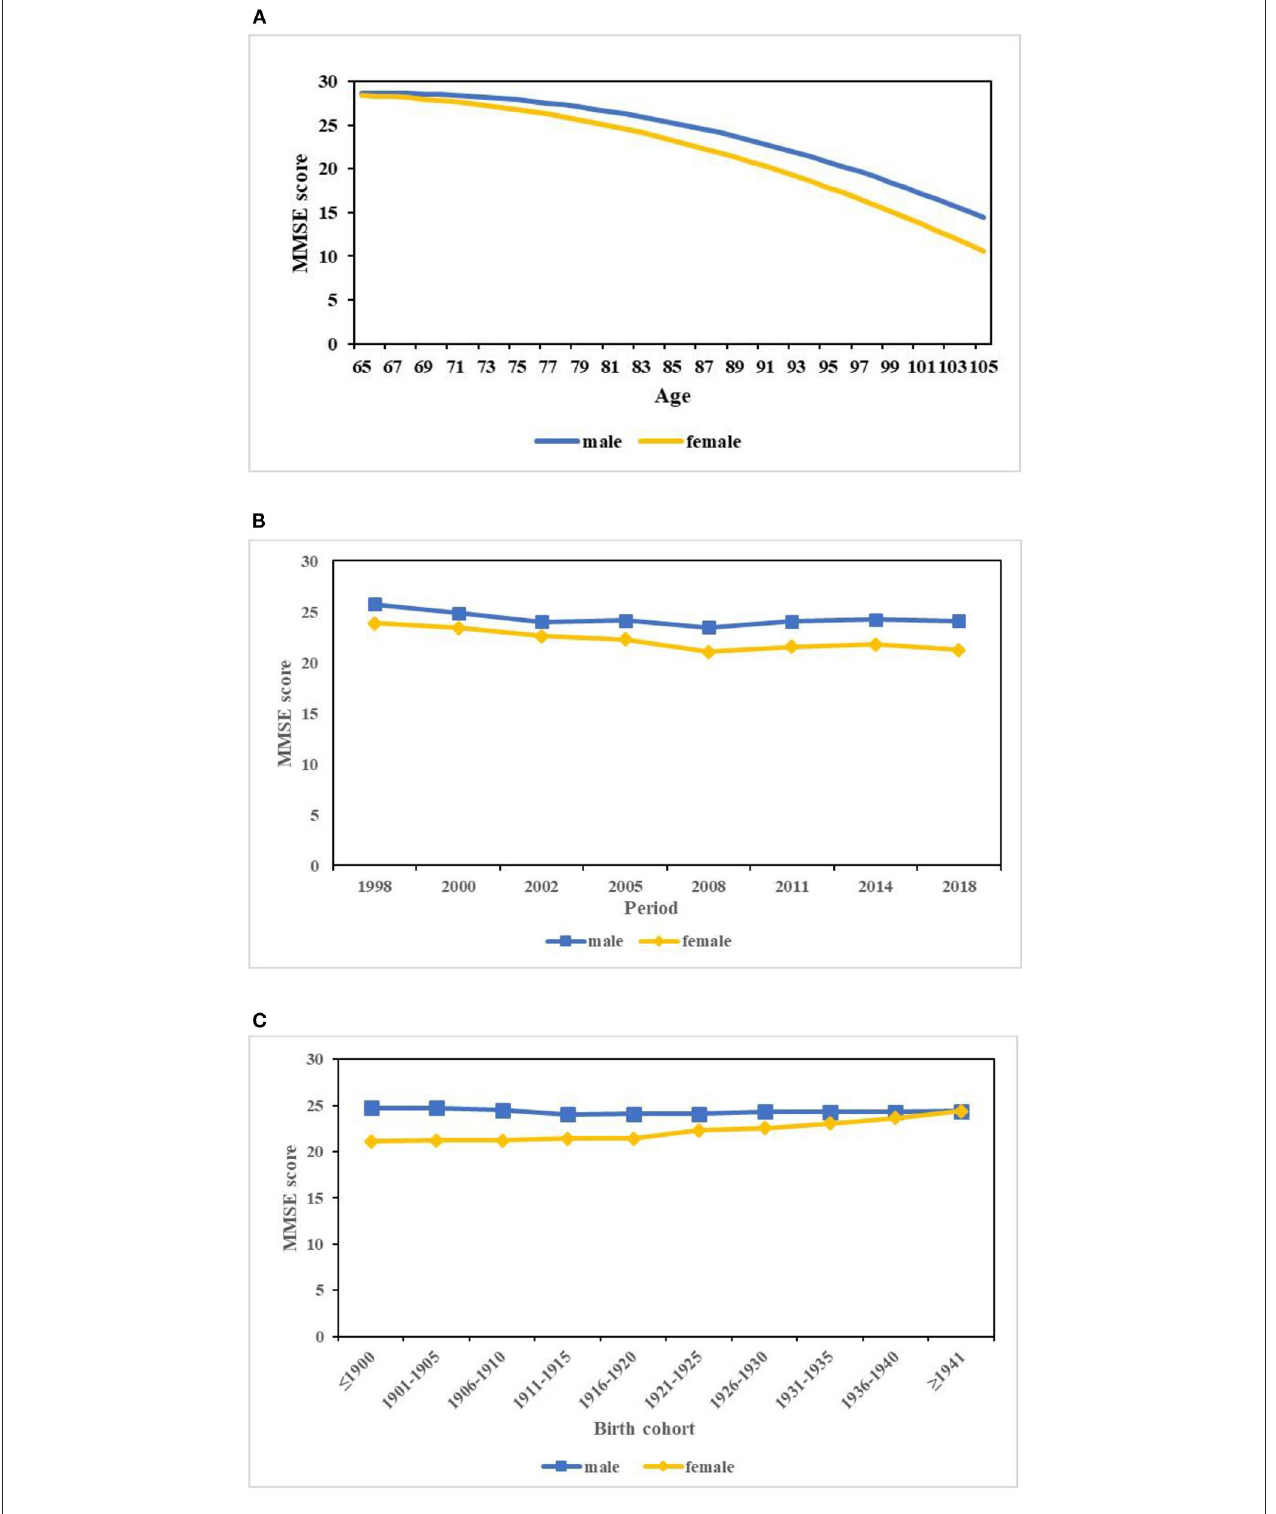
FIGURE 2 | Predicted age, period, and cohort trends in the gender disparity in MMSE scores. (A) Age. (B) Period. (C) Cohort.